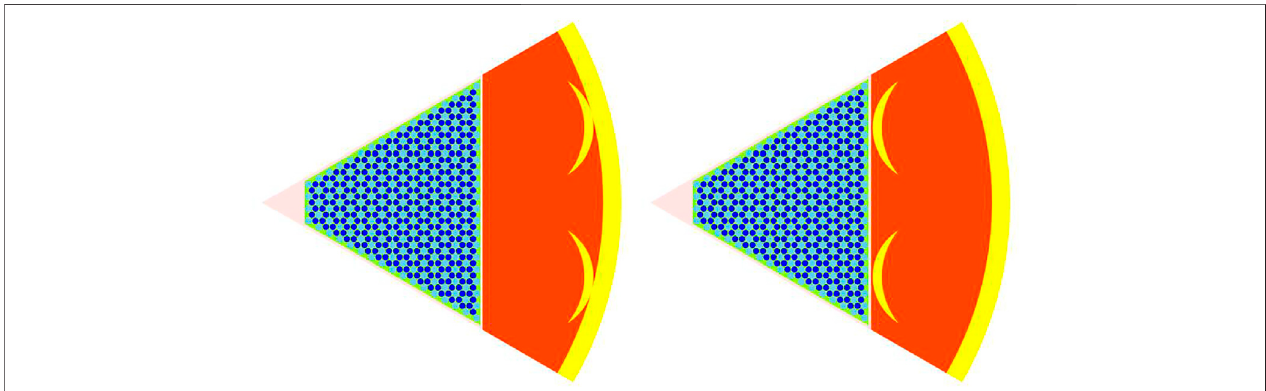
FIGURE 3 | The con fi guration of cases A and D in Ref. (Lee et al., 2019). The angle of two control drums in each case are respectively (0 ° , 0 ° ), (180 ° , 180 ° ).